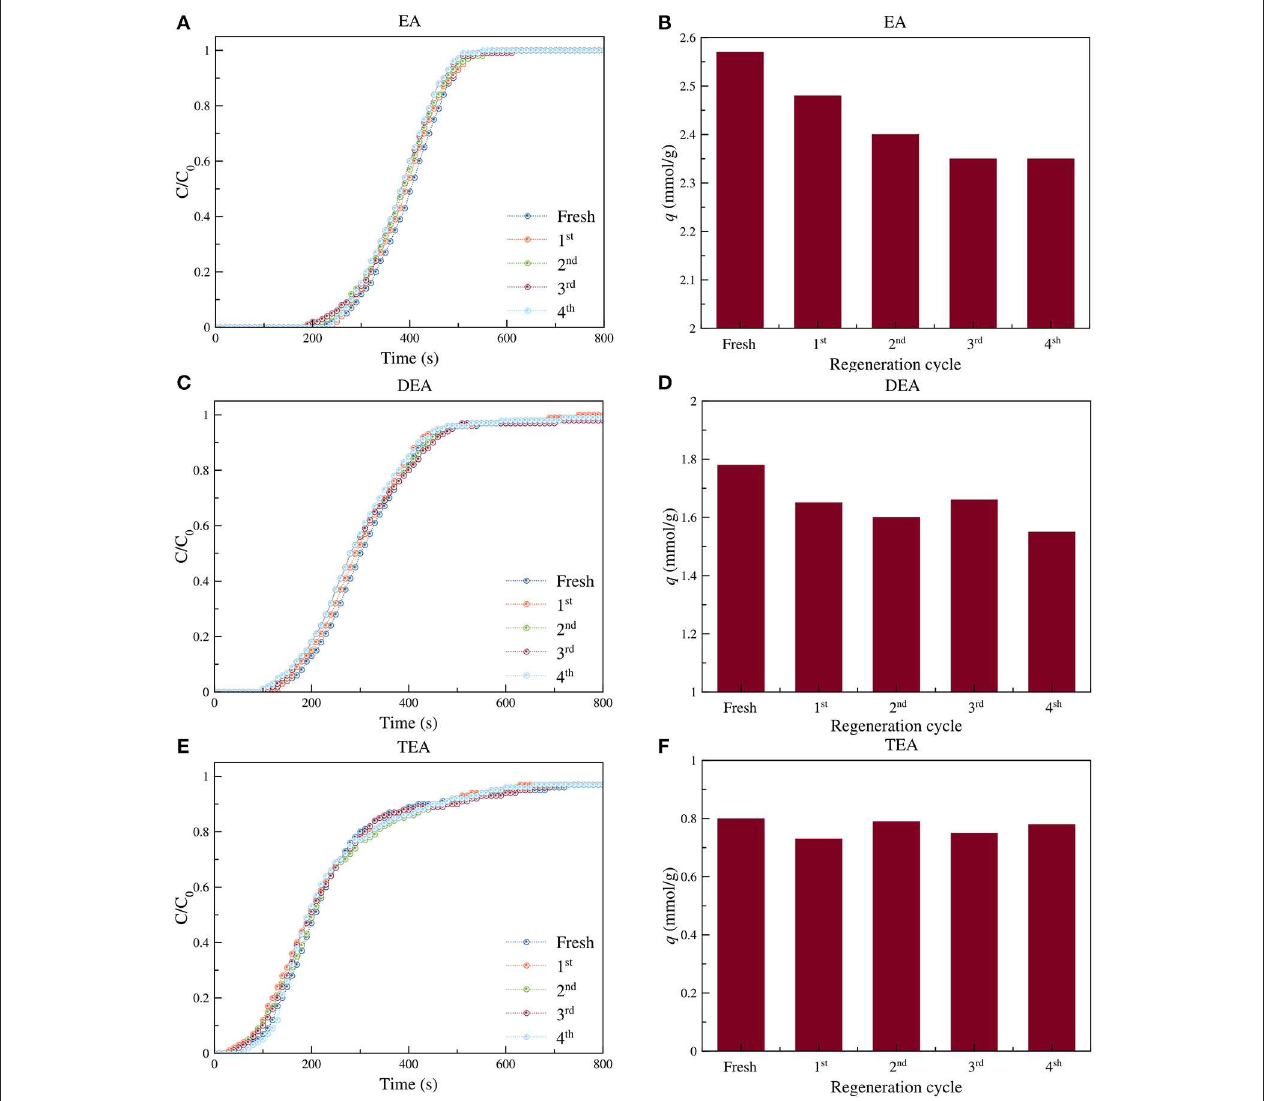
FIGURE 9 | Breakthrough curves of CO 2 adsorption on fresh and regenerated adsorbents (A,C,E) and CO 2 adsorption capacities (B,D,F) at each regeneration cycle (C = 10%; P = 1 bar and flow rate = 50 ml/min) for EA (A,B) , DEA (C,D) , and TEA (E,F) aminated